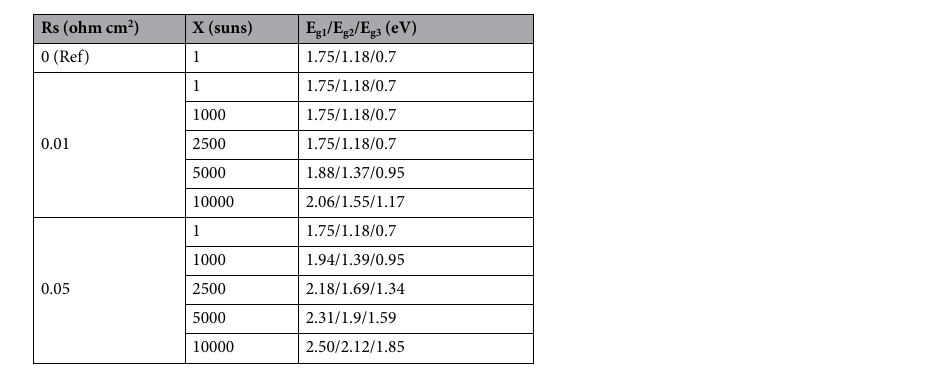
Table 1. Optimal combination of bandgaps of a 3-J cell architecture, for illumination levels comprised between 1 and 10,000 suns, and for a total series resistance value of 0, 0.01 and 0.05 Ω cm 2